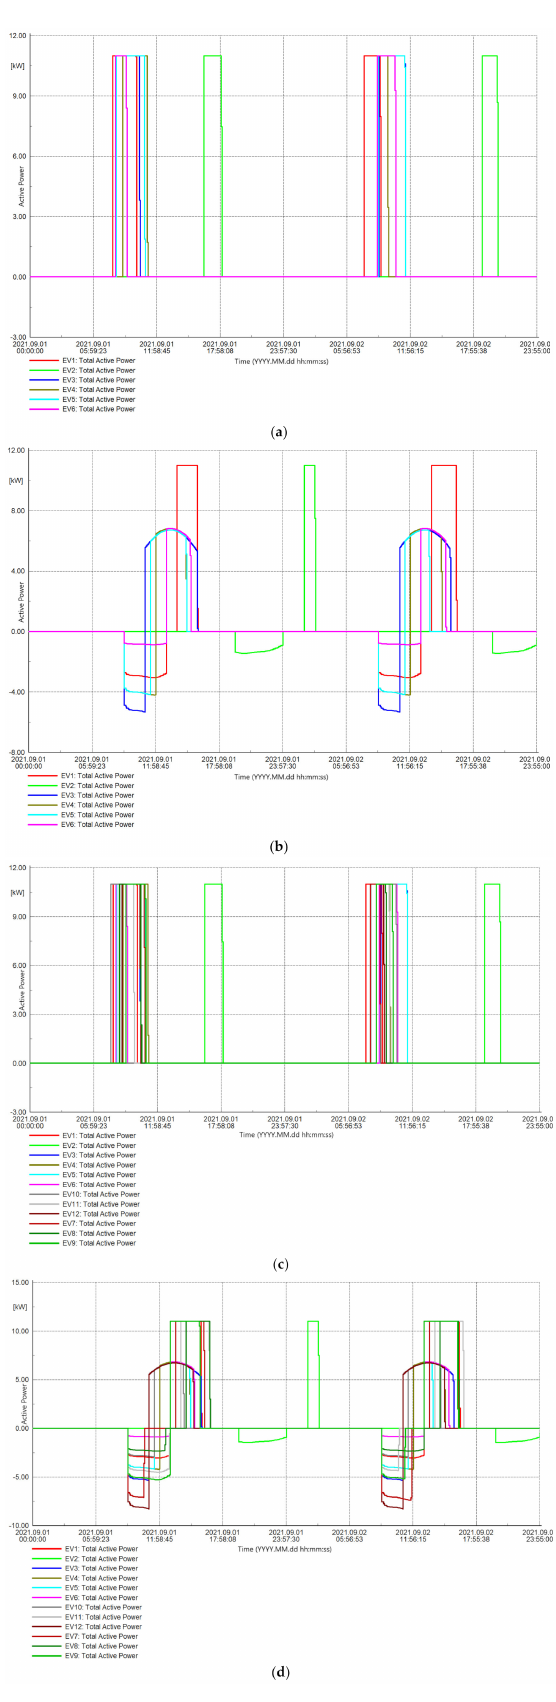
Figure 4. The EVs profiles in: ( a ) scenario 2; ( b ) scenario 3; ( c ) scenario 4; ( d ) scenario